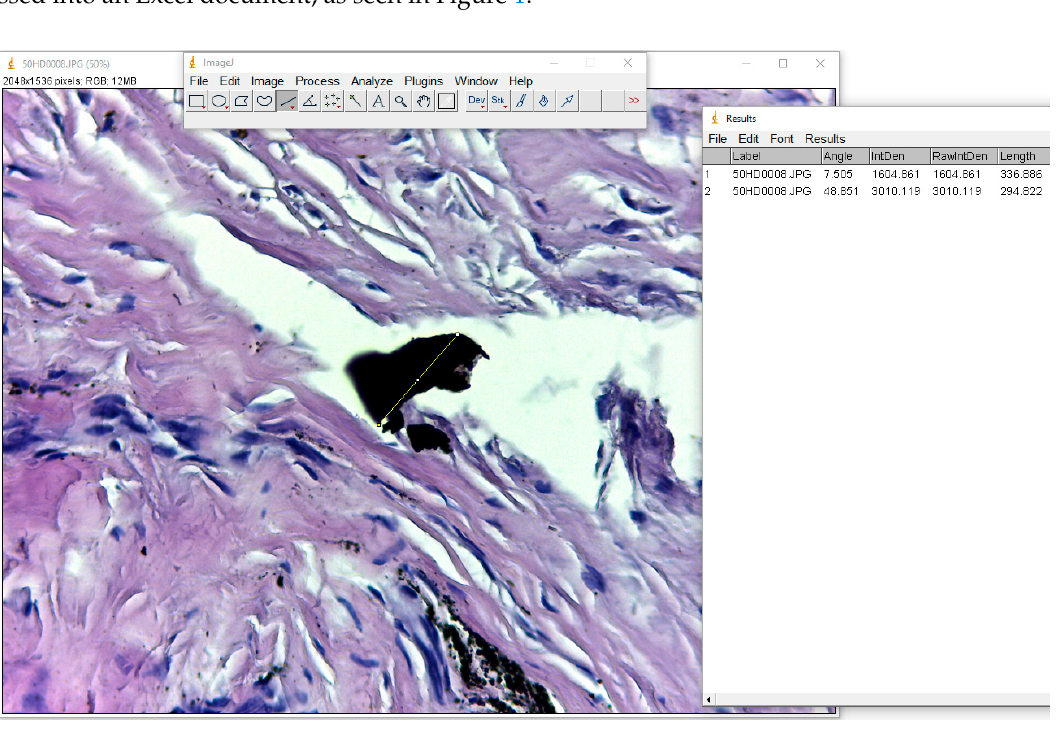
Figure 1. Morphometric analysis of debris particles in ImageJ software.